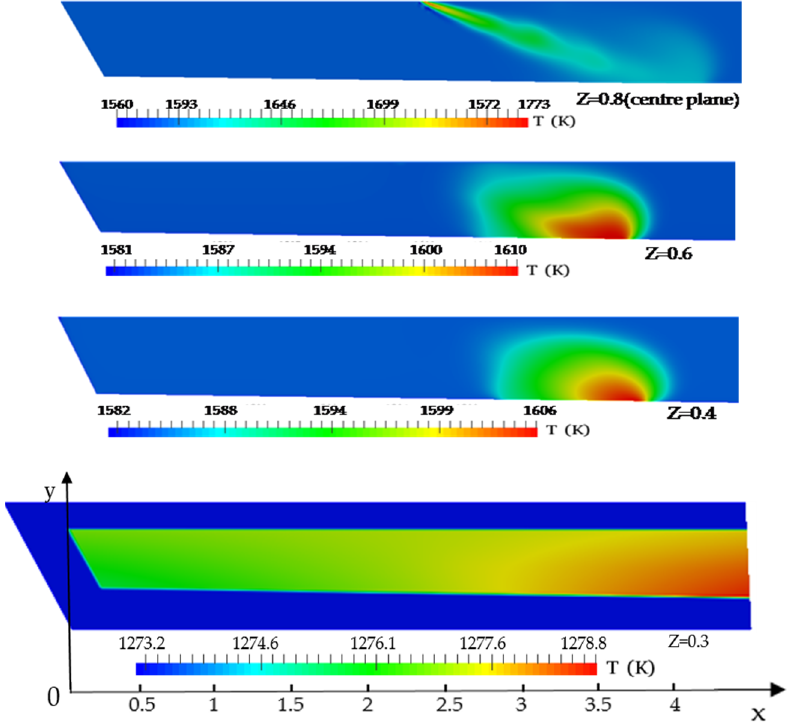
Figure 11. Temperature distributions from the central plane to plane 3 (cf. Figure 3a).